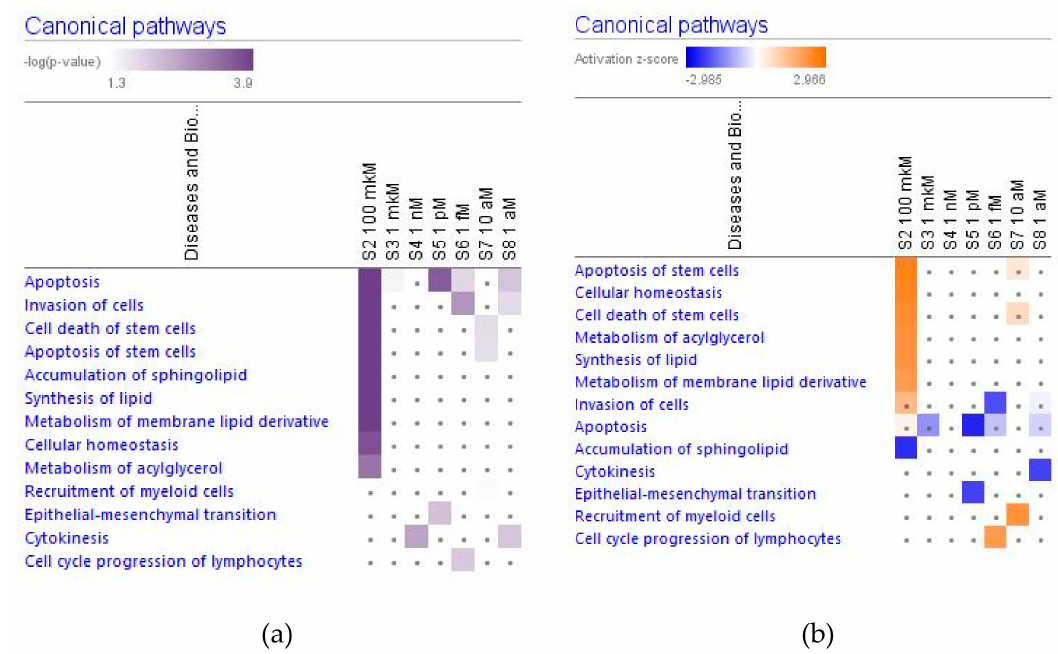
Figure 17. Effect of Rg5 at concentrations of 1 aM, 10 aM, 1 fM, 1 pM, 1 nM, 1 µ M and 100 µ M) on molecular and cellular functions (including apoptosis of neurons). ( a ) the brown color shows the predicted activation, blue color the predicted inhibition of signaling pathway; the symbol shows that the activation z-score was <2. ( b ) the symbol shows that the − log p − value was